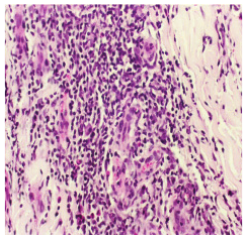
Figure 2 - Skin fragment demonstrating irregular acantosis on the epidermis. Mononuclear inflammatory infiltrate which follows the course of the skin blood vessels. (40X).